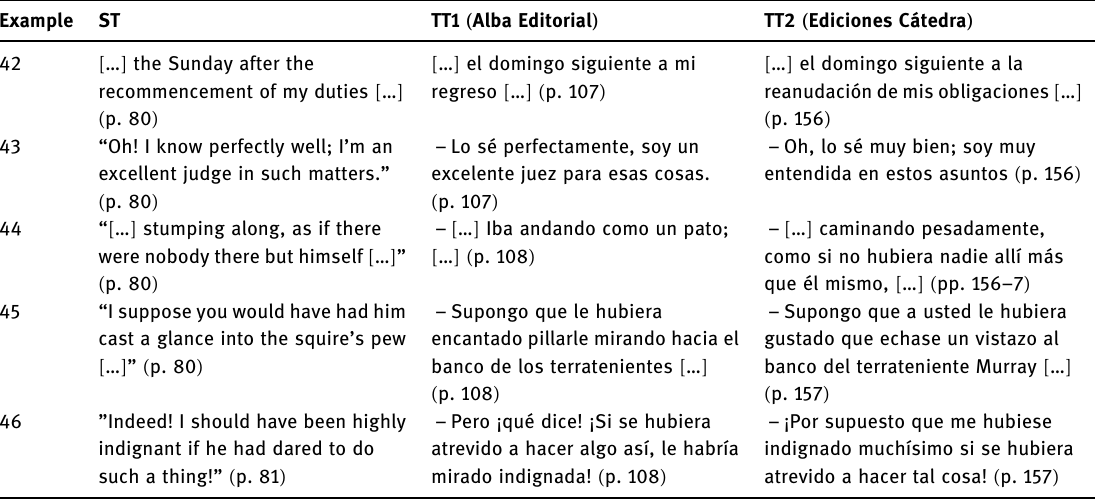
Table 9: Examples taken from Chapter 10 Example